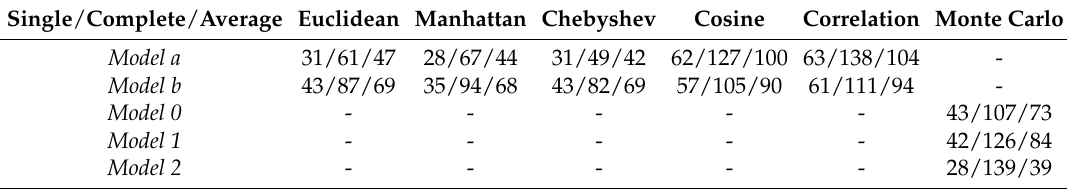
Table 3. The total number of proper groups